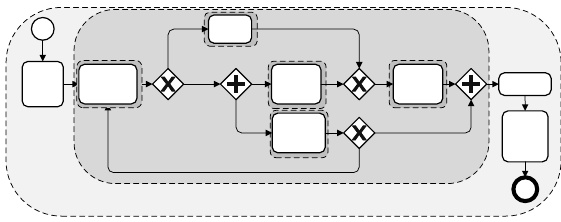
Figure 29. Failure trace up to a deadlock and abundance in the example workflow